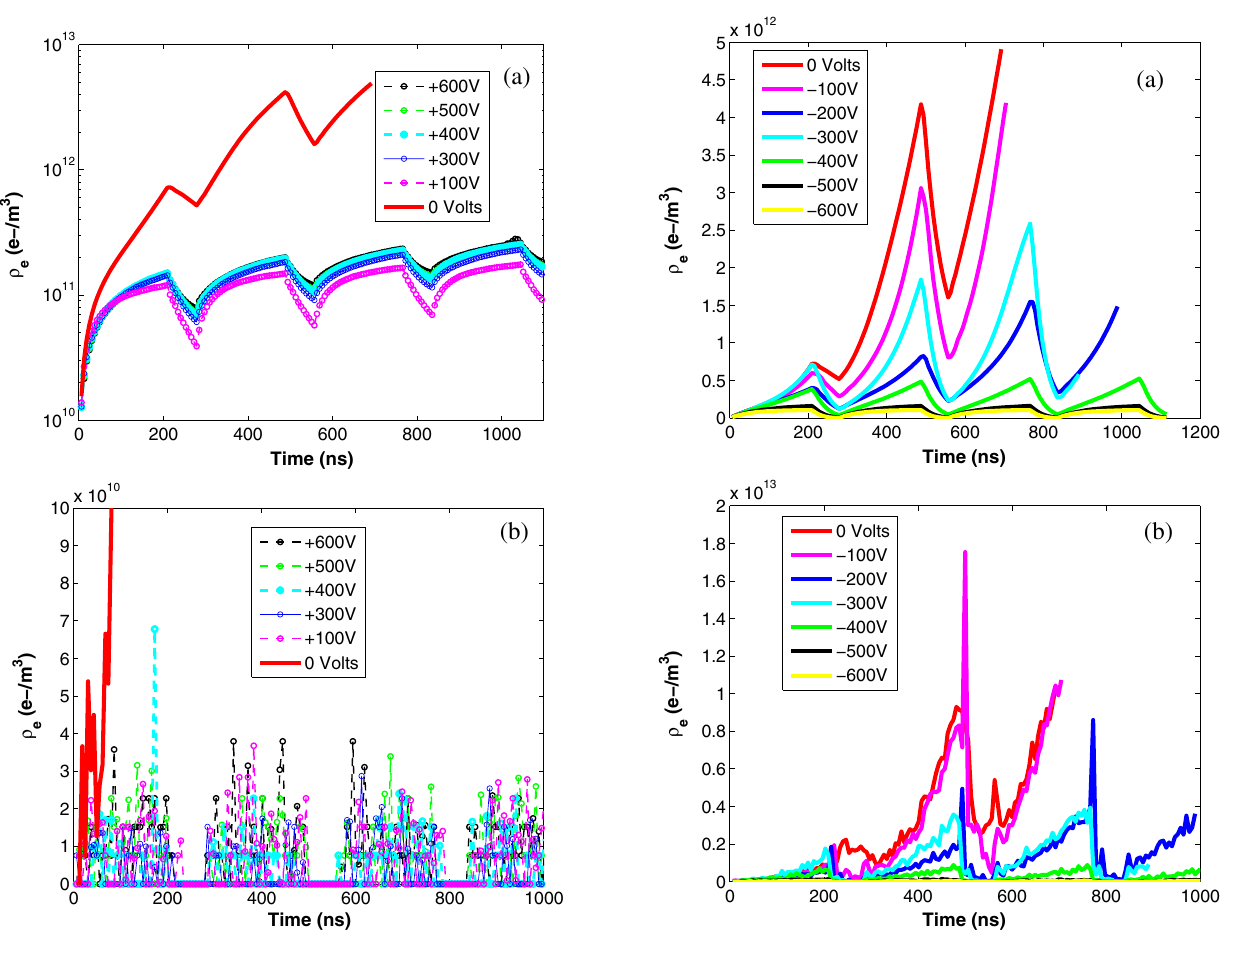
FIG. 17. Simulated buildup of the EC at the center of a wiggler pole with a positive clearing voltage applied: (a) cloud density averaged over the vacuum chamber, (b) central cloud density.